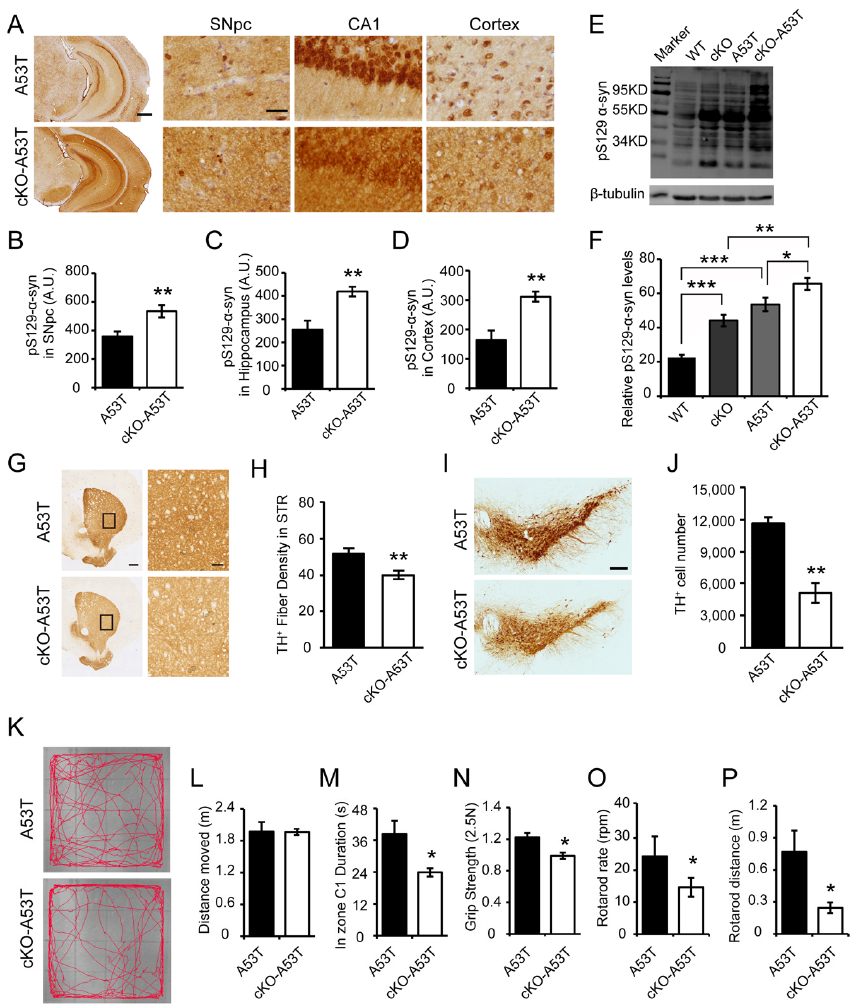
Figure 3. Genetic deletion of Thorase in the brain exacerbates α -synucleinopathy and behavioral impairments in PD A53T mice. ( A ) Representative images of pS129- α -syn immunohistochemical staining in the SNpc, hippocampus and cortex in sections from Thorase cKO-hA53T α -syn (cKO-A53T) and A53T littermate mice at the age of 5 months. Scale bars, 1 mm for low magnification and 15 µ m for high magnification. Anti- α -syn (phospho S129) antibody (Abcam, 1:1000). ( B – D ) Quantification of the immunohistochemical staining of pS129 α -syn in sections of the SNpc ( B ), hippocampus ( C )